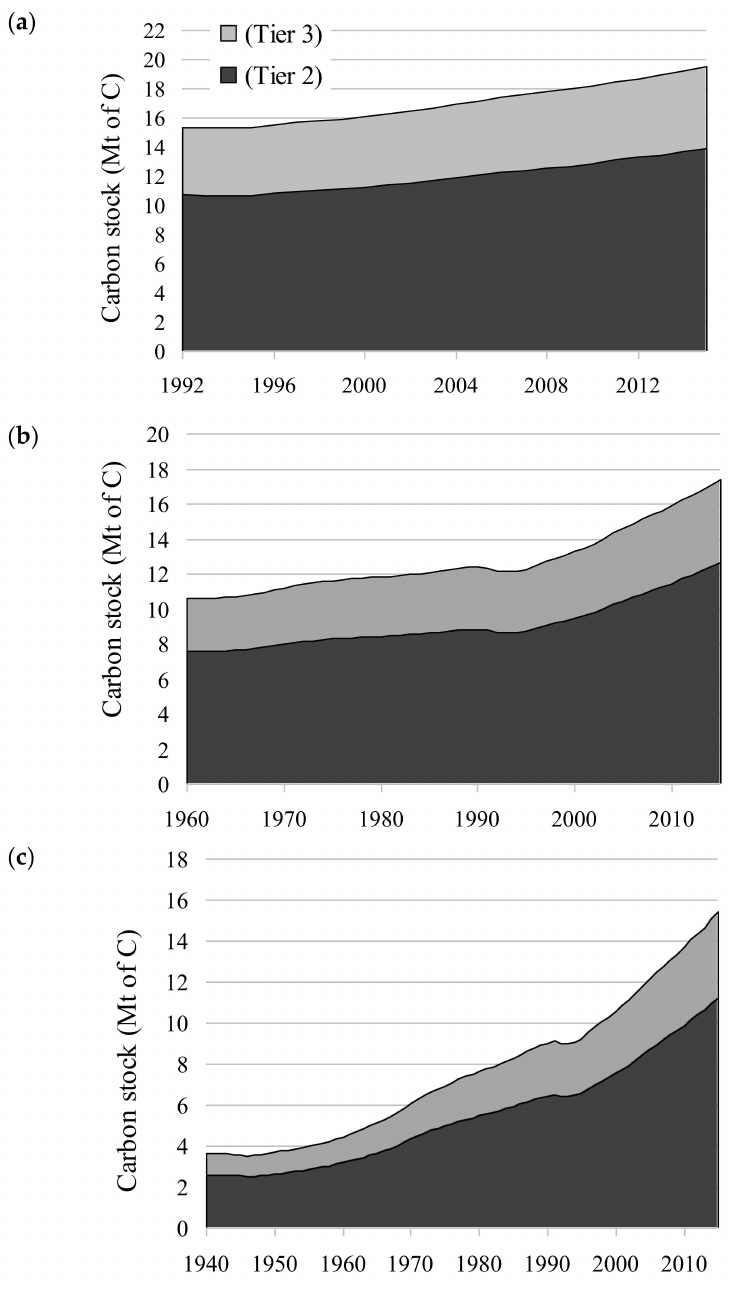
Figure 1. Total carbon stocks in harvested wood products (HWP) under the Intergovernmental Panel on Climate Change (IPCC) Tier 2 and Tier 3 methods: ( a ) Estimates based on available Food